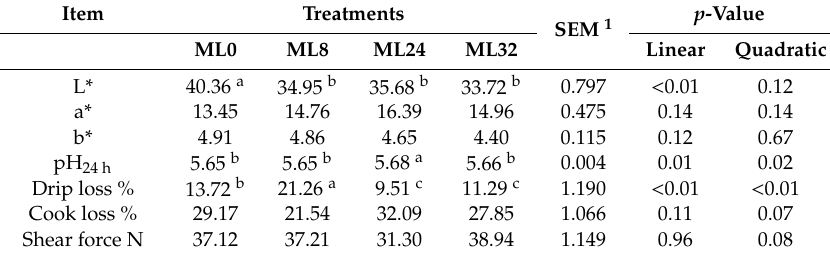
Table 7. E ff ects of inclusive ML treatments on meat quality of